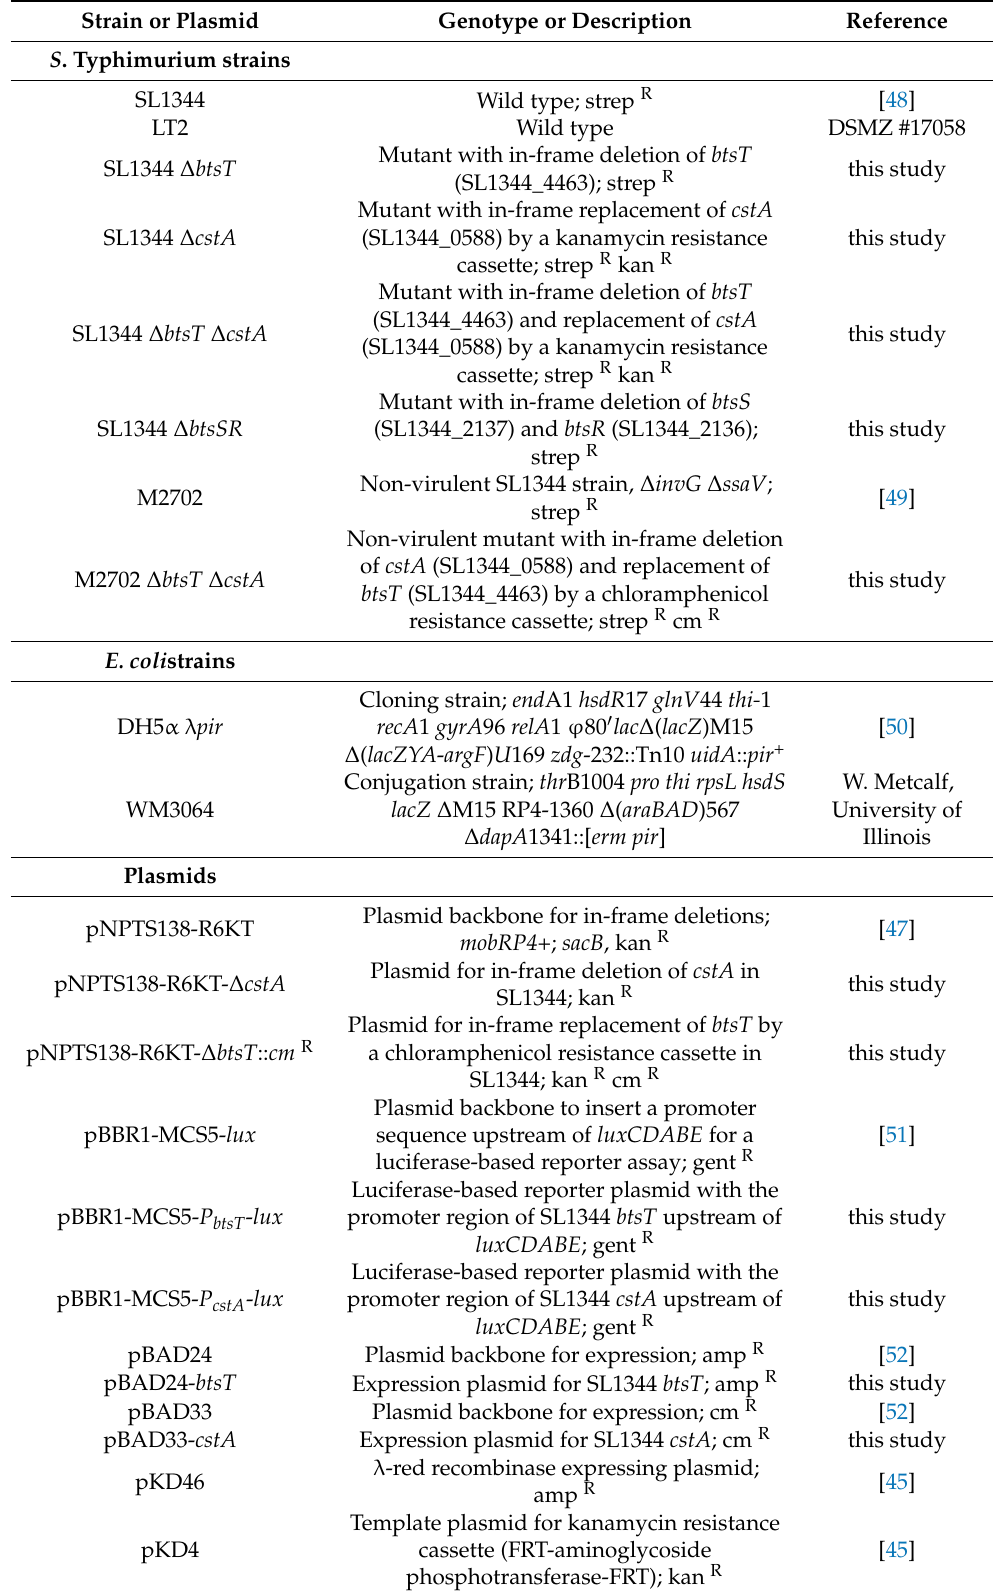
Table 1. Strains and plasmids used in this study. ( R